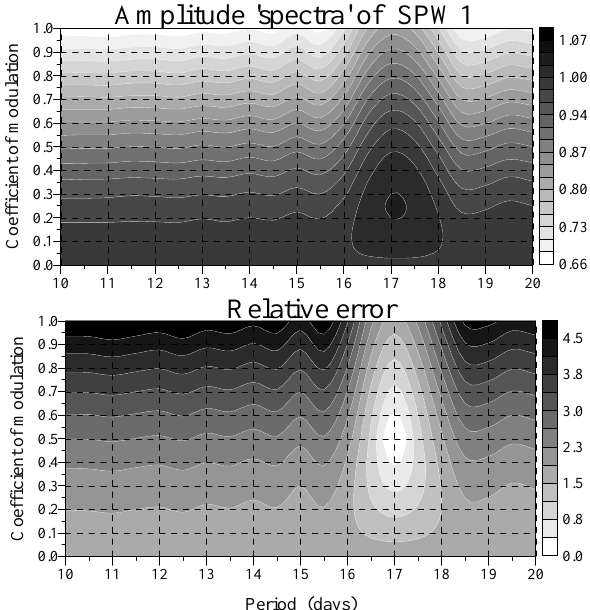
Figure 1 Fig. 1. Upper plot: Amplitude “spectra” of the simulated by Eq. (1) SPW1 (for details see the text) derived from the data of the entire time series; the procedure for least squares best fitting is performed for periods of the modulating oscillation from 10 to 20 days with a step of 0.5 day, phases from − 180 ◦ to 180 ◦ with a step of 1 ◦ and for coefficients of modulation changing from 0 to 1 with a step of 0.1; bottom plot: Relative errors of the “spectra” expressed by the standard deviation of the approximation normalized by the effective √ wave amplitude (the amplitude divided by